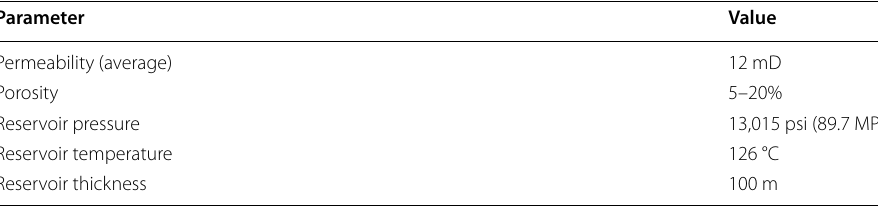
Table 3 Reservoir-prototype characteristics Parameter